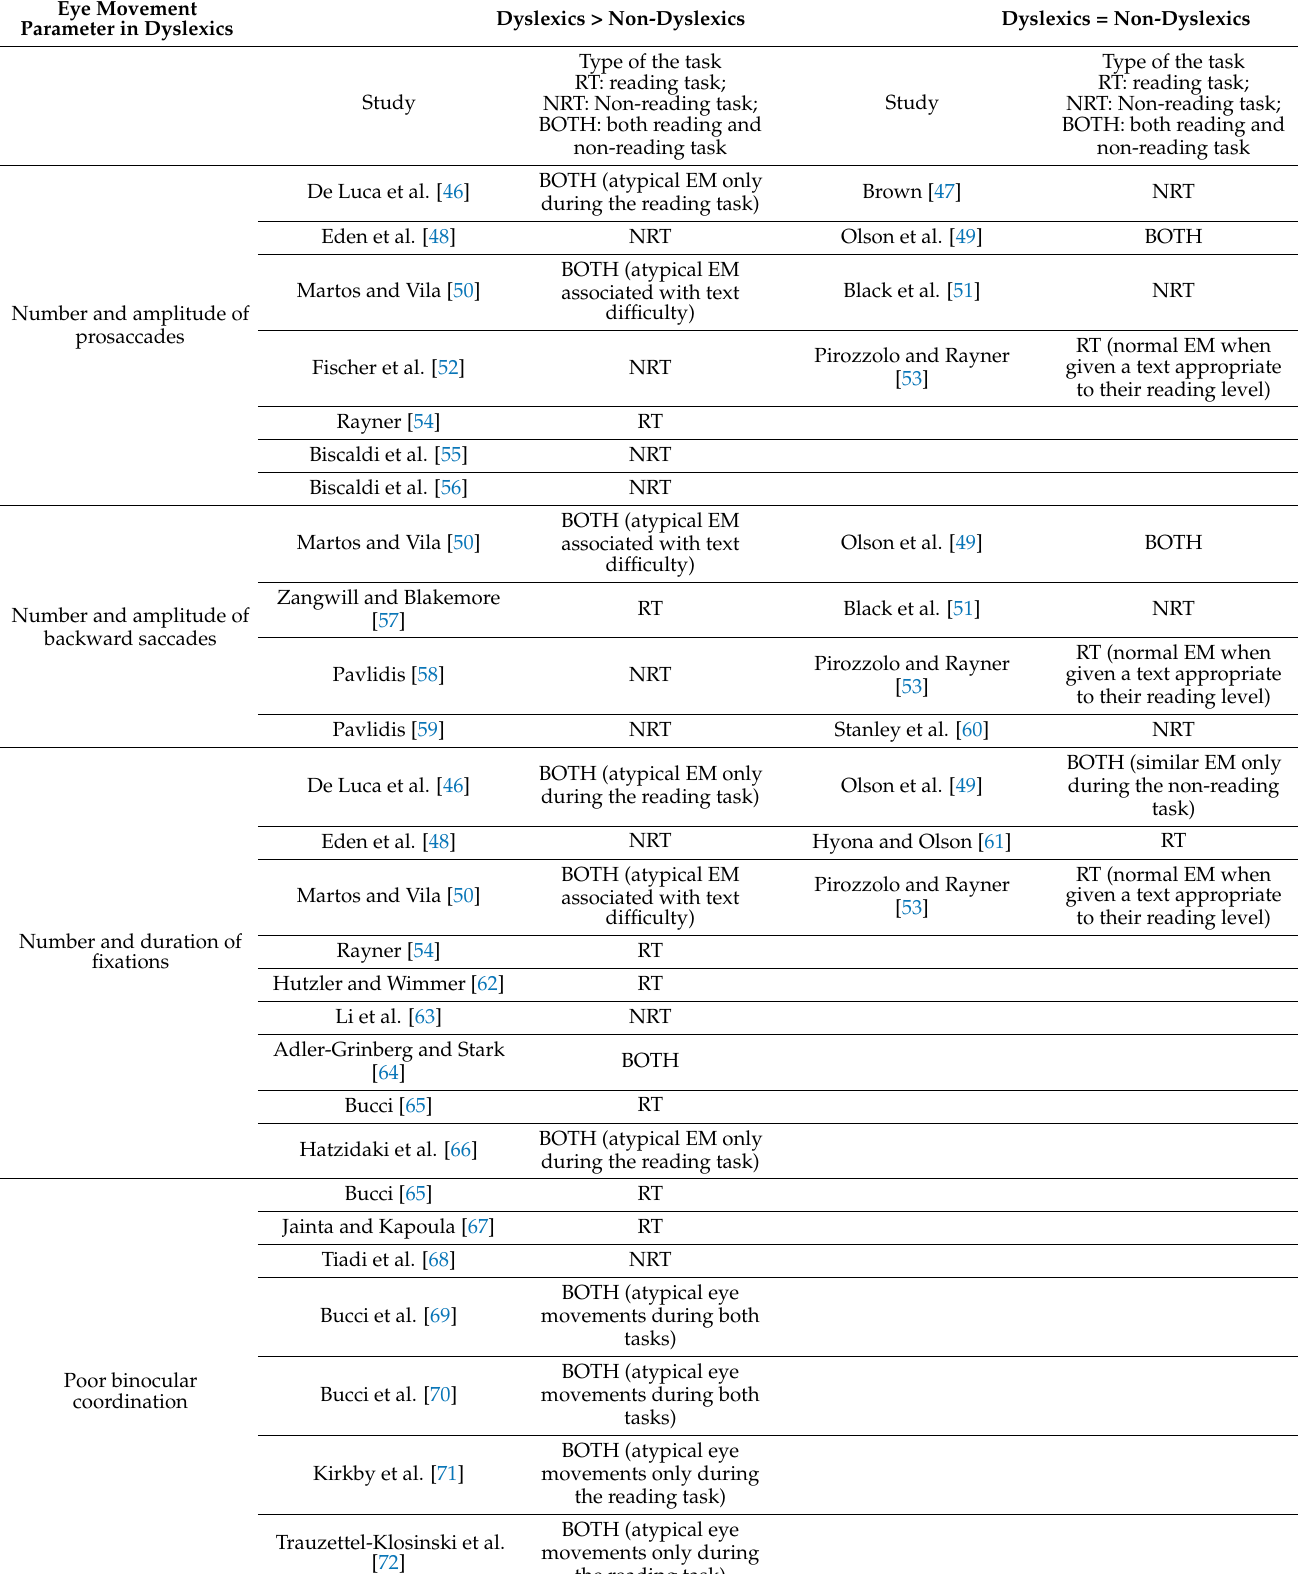
Table 2. Summary of the studies that found atypical and typical eye movement parameters in